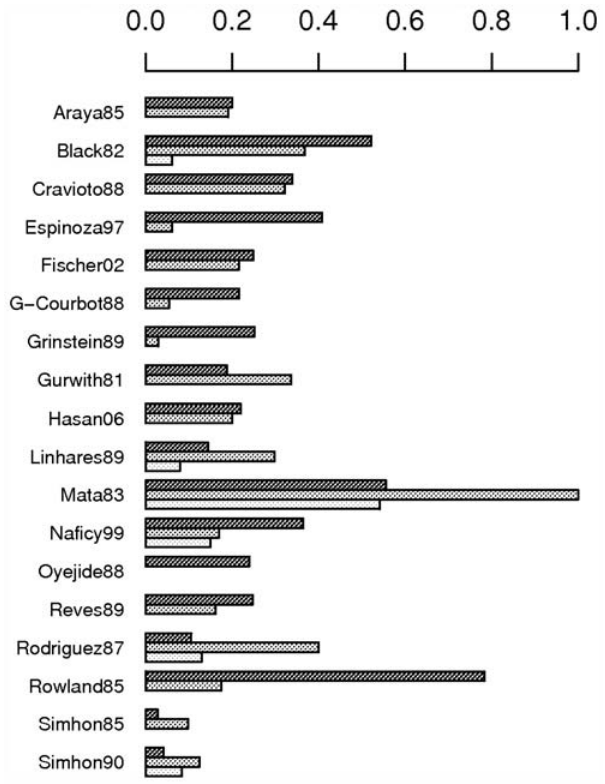
Figure 3. Incidence of symptomatic RV infections by age (in years) obtained from different studies. Incidence is number of symptomatic RV infections per personyear of observation. Black, grey and white bars represent incidences for children in their first, second and third year of life, respectively.